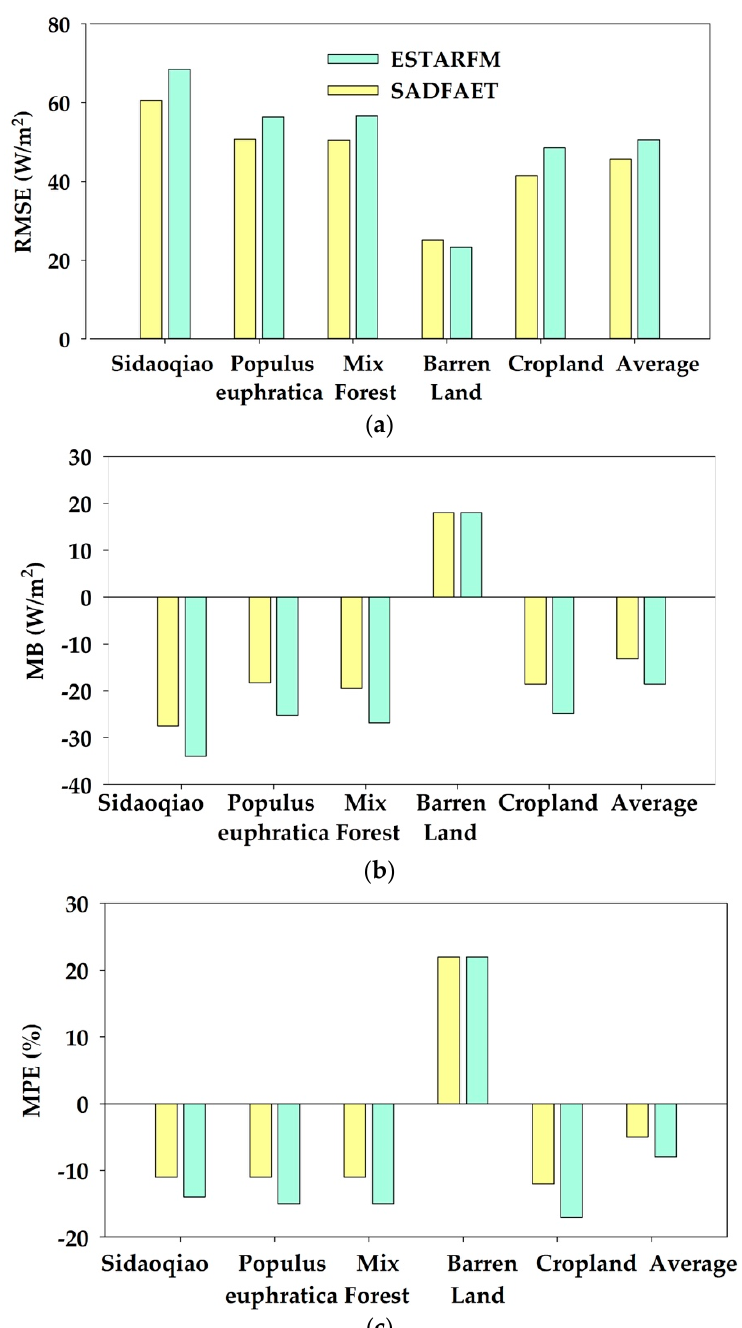
Figure 6. Statistical parameters between the instantaneous LE predictions using ESTARFM/ SADFAET and the EC values: ( a ) RMSE; ( b ) MB; ( c ) MPE.